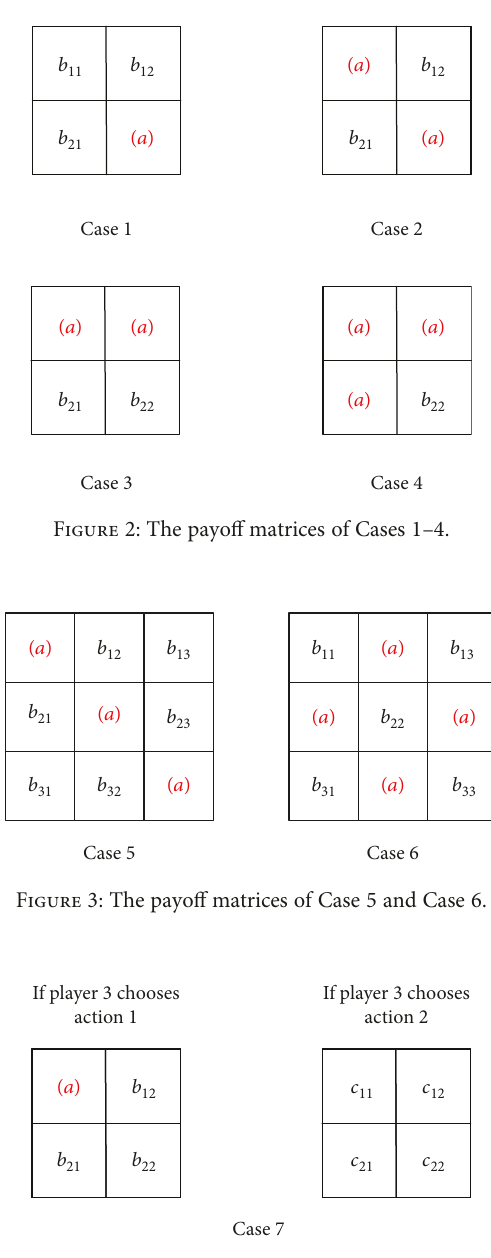
Figure 4: The payo ff matrix of Case